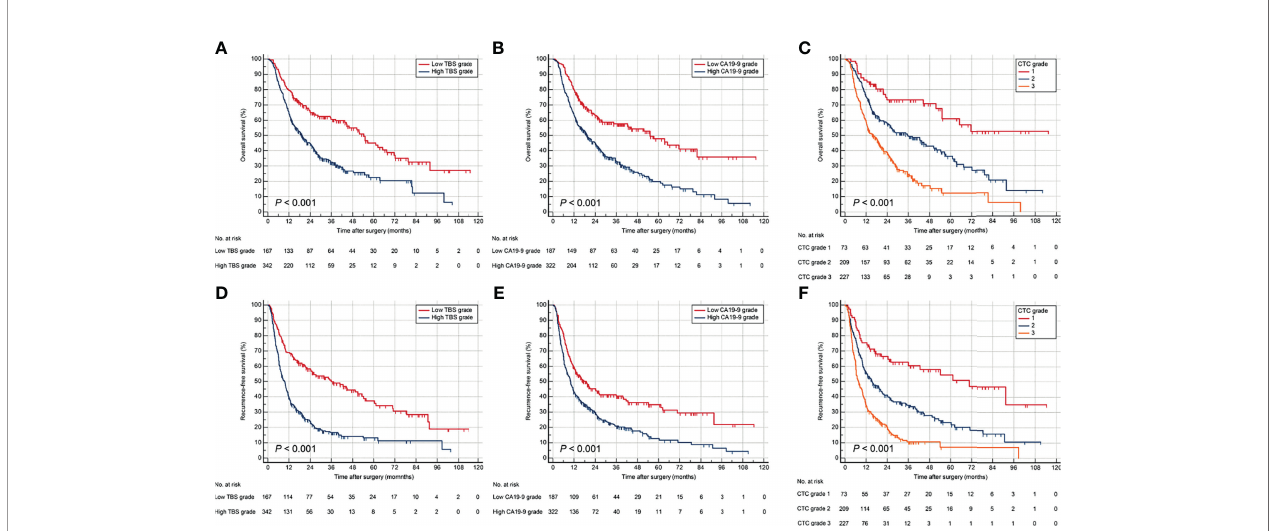
FIGURE 2 | Kaplan – Meier curves for OS and RFS strati fi ed by TBS (A, D) , CA19-9 (B, E) , and CTC grade (C, F) in the derivation cohort. OS, overall survival; RFS, relapse-free